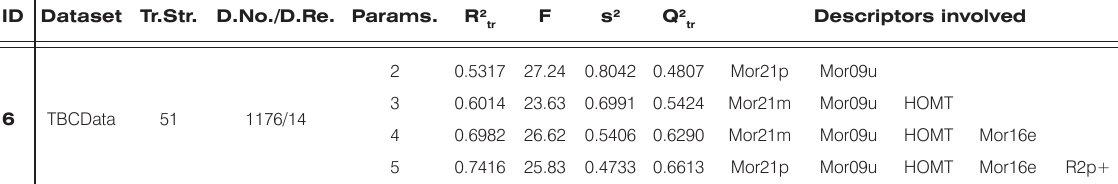
c) MLR models obtained by employing a combination of 3D+QC molecular descriptors (Supporting Information Supplemental Table 3, case 6). ID Dataset Tr.Str. D.No./D.Re.